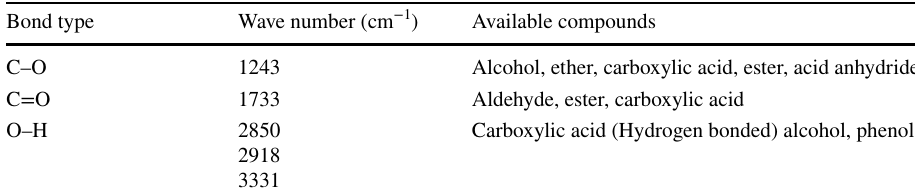
Table 1 Active functional groups present in the peel of Artocarpus nobilis fruit